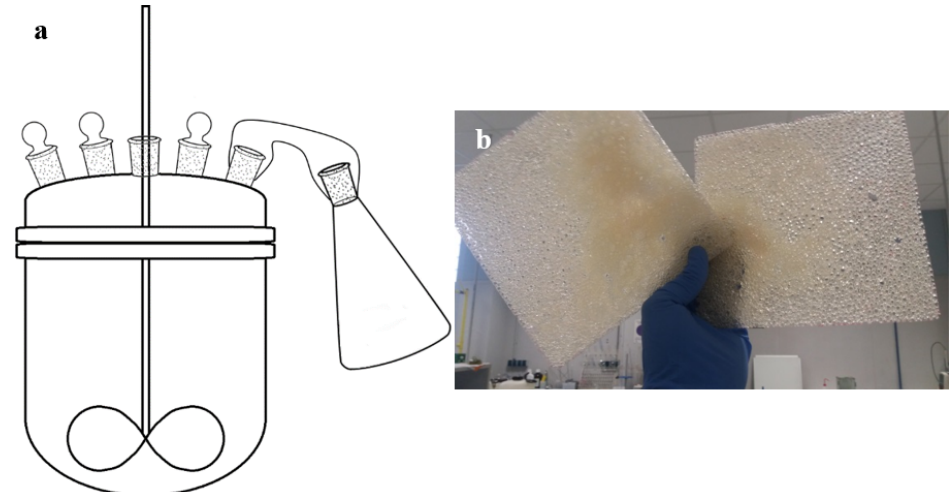
Figure 1. ( a ) Scheme of the reactor setup for glycerol phosphorylation. ( b ) Oven-cured phosphate- containing polyester.